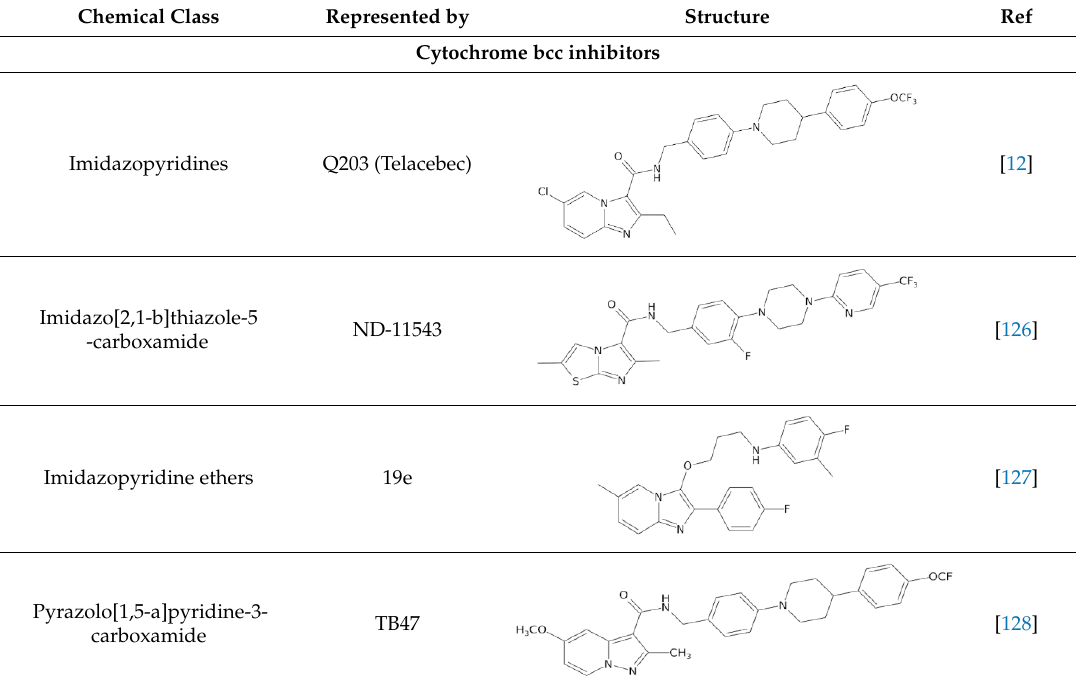
Table 3. Inhibitors of the Cyt-bcc-aa3 complex and the bd oxidase discussed in this review.